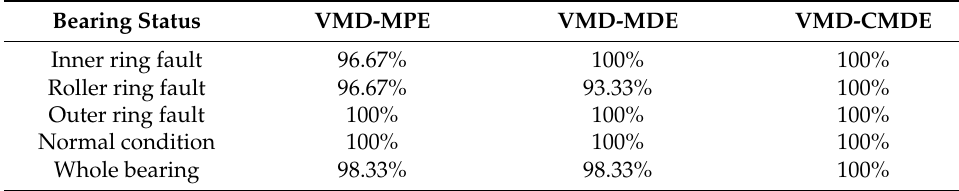
Table 5. PSO-DBN model